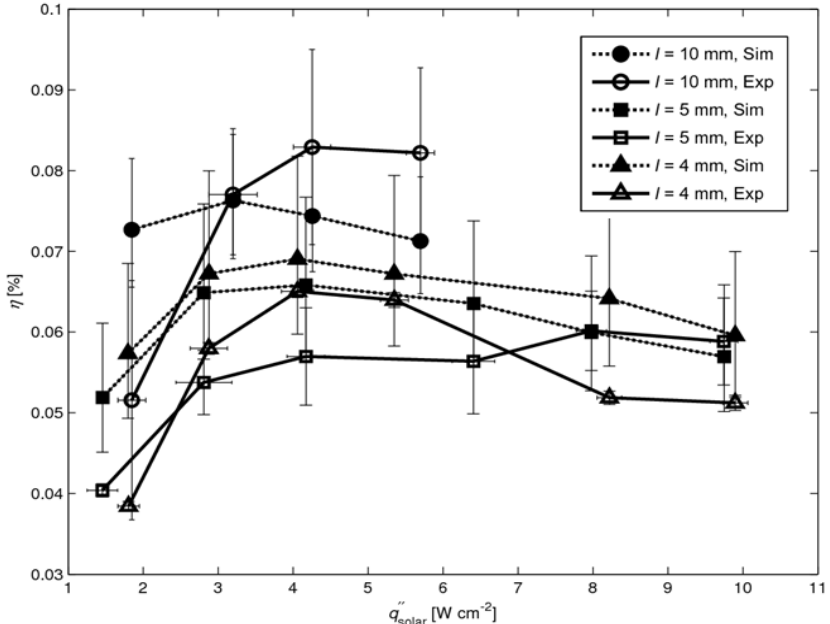
Figure 10. Simulated and experimental η as a function of solar radiative flux for l = 4, 5, 10 mm (experimental data from Figure 6). Error bars for simulated data points indicating uncertainty of contact